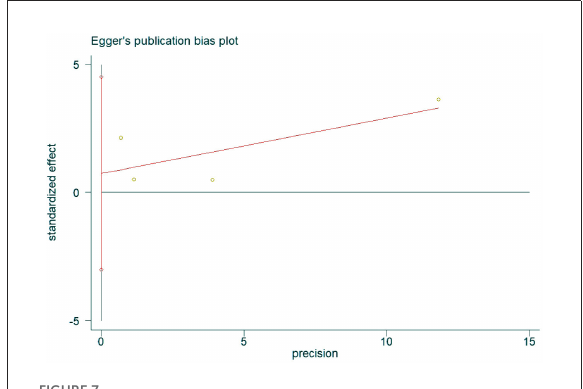
FIGURE7 Funnel plot of Egger’s method to assess publication bias in incidence of hearing loss in OASHS vs. control.